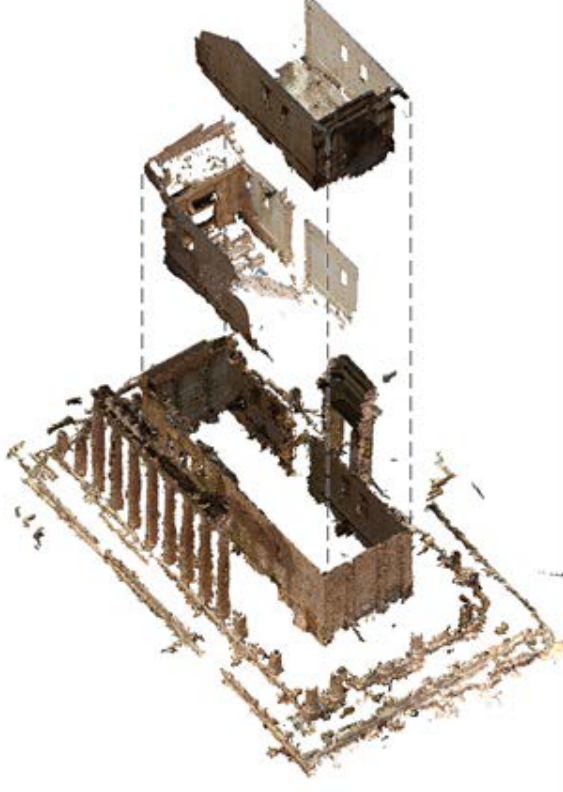
Figure 6. Three groups of images created three point clouds of the temple to be relatively georeferenced.